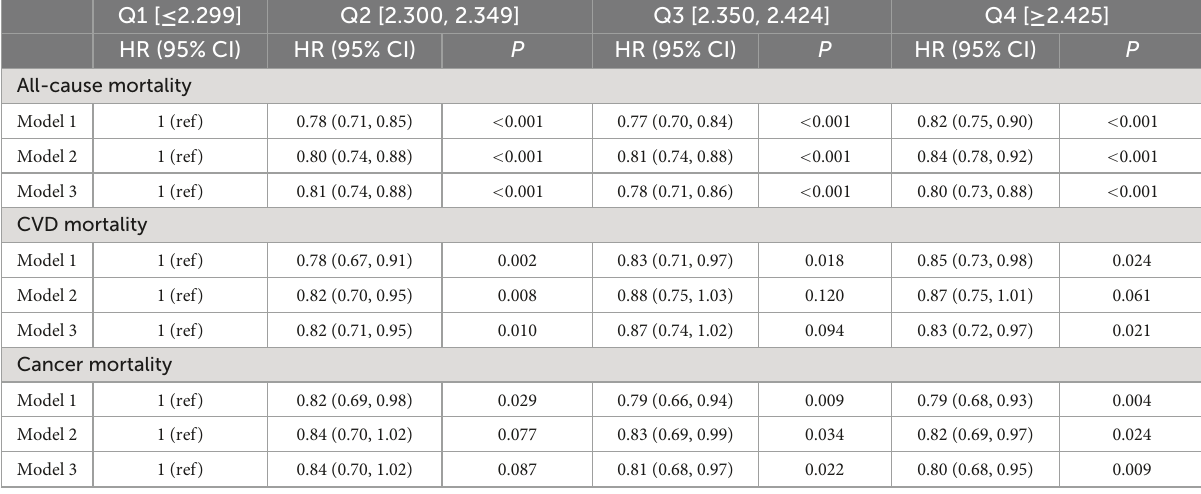
TABLE 2 Multivariate analysis of the association between serum calcium level quartiles and mortality. Q1 [ ≤